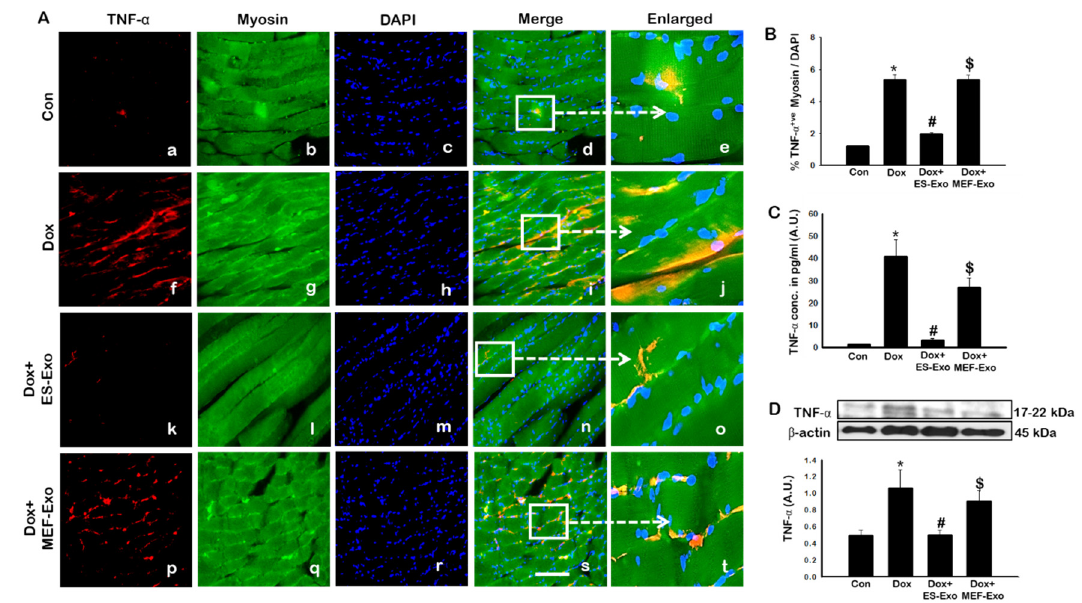
Figure 8. ES-Exos treatment attenuates Dox-induced release of pro-inflammatory cytokine, TNF- α . ( A ) Representative photomicrographs of soleus muscle sections stained with myosin and pro-inflammatory cytokine, TNF- α . Each box shows TNF- α + cells in red ( a , f , k , p ), myocytes in green ( b , g , l , q ), DAPI in blue ( c , h , m , r ), merged images ( d , i , n , s ), and enlarged areas of merged images ( e , j , o , t ). ( B ) Histograms from quantitative analysis of TNF- α + cells over total DAPI. ( C ) Quantification of ELISA analysis for TNF- α . ( D ) Representative blot and densitometric analysis of TNF- α . Error bars = mean ± S.E.M. * p < 0.05 vs. control, # p < 0.05 vs. Dox, $ p = non-significant vs. Dox, one-way ANOVA followed by Tukey test; western blot and ELISA quantities are represented as A.U. Scale bar = 100 µ m, n = 14–16, male and female ( B ) and n = 6–8, male and female ( C , D ). Images taken at 40 × magnification.